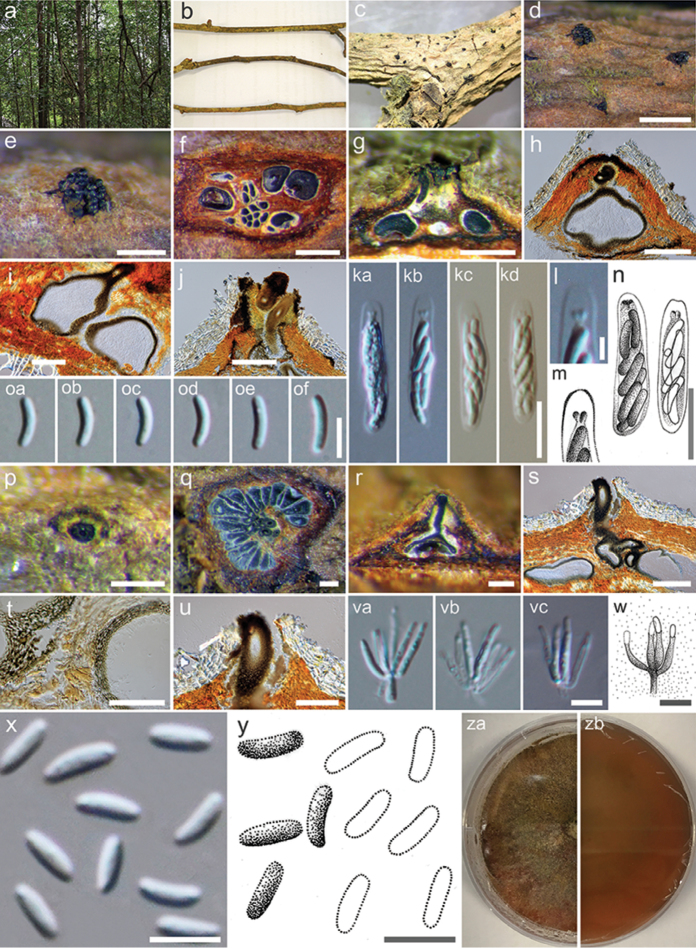
Cytosporathailandica (MFLU 17-0709, holotype). aXylocarpusmoluccensisb Branch of XylocarpusmoluccensiscAscostromata on host substrate d, e Surface of ascomata f Transverse sections through ascostroma to show distribution of locules g–h Longitudinal sections through ascostroma to show distribution of locules iPeridiumj Ostiolar neck ka–kd, n Asci l, m Apical ring oa–ofAscosporesp Surface of conidioma q Transverse sections through conidioma to show distribution of locules r, s Longitudinal sections through conidioma to show distribution of locules tPeridiumu Ostiolar neck va–vc, w Conidiogenous cells with attached conidia x, yConidiaza, zb Colonies on MEA (za-from above, zb-from below). Scale bars: d = 1000 µm, e–g = 400 µm, h, j, p–s = 200 µm, i, u = 100 µm, ka–kd, n = 10 µm, l, m = 2 µm, oa–of, va–vc, w = 5 µm, t = 50 µm, x, y = 4 µm.